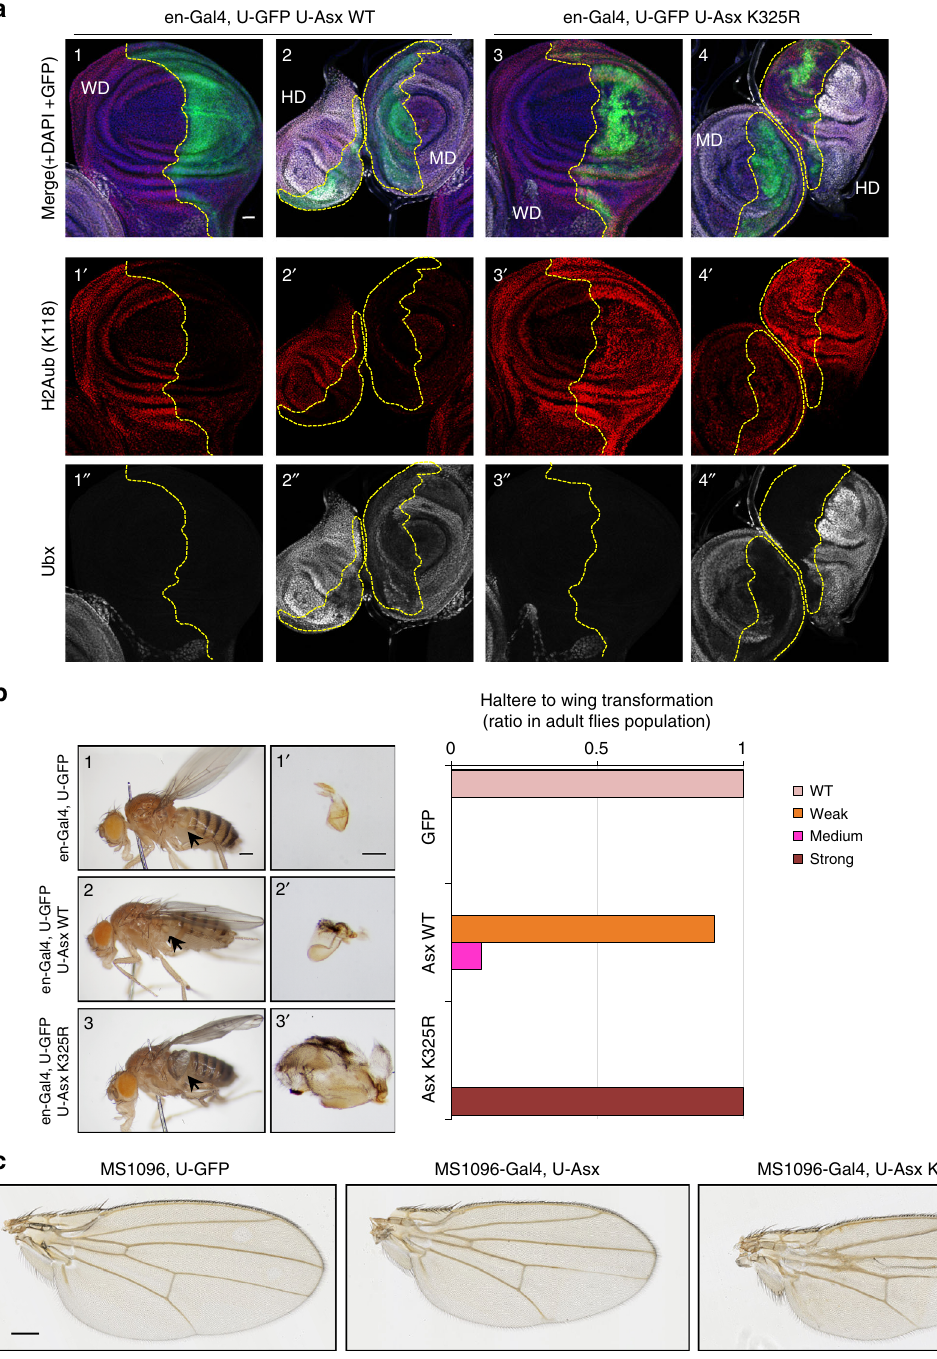
Fig. 8 Expression of Asx K325R results in haltere to wing transformation. a Effect of the expression of Asx WT or K325R mutant during Drosophila larval disc development. Discs were stained with anti-H2Aub (red), anti-Ubx (white) and DAPI (blue). GFP (green) indicates expression pattern of en-Gal4 and is delimited by dashed lines. Genotypes are indicated (see also Supplementary Fig. 8). Scale bar: 20 µ m. n = 3 biological replicates. b Partial haltere to wing homeotic transformation associated with expression of Asx K325R. Phenotypes associated with the expression of Asx K325R in adult Drosophila . Left panel, images showing whole Drosophila animals and dissected halteres. Right panel, quanti fi cation of haltere to wing transformation phenotype. The arrows indicate the halteres. n = 3 biological replicates. Scale bar: 200 µ m for images 1, 2 and 3. Scale bar: 100 µ m for images 1 ′ , 2 ′ and 3 ′ . c Wing development defects following expression of Asx or Asx K325R. Scale bar: 200 µ m. n = 3 biological replicates. WD wing imaginal disc, HD Haltere imaginal disc, MD mesothoracic leg imaginal UBE2E2 and ASXL2 ( r = 0.55, p = 0.01), followed by UBE2E2 ASXL2 ( r = 0.90, p = 0.0004), followed by UBE2E2 and UBE2E3 and UBE2E3 ( r = 0.49, p = .03), and UBE2E3 and ASXL2 ( r = 0.50, p = 0.14), and UBE2E3 and ASXL2 ( r = 0.48, p = 0.16) ( r = 0.32, p = .17). When restricting the analysis to wild-type only (Fig. 9j and Supplementary Fig. 11a). These results suggest that ( N = 10), the strongest association was still between UBE2E2 and BAP1, ASXL2, and UBE2Es expression are correlated in